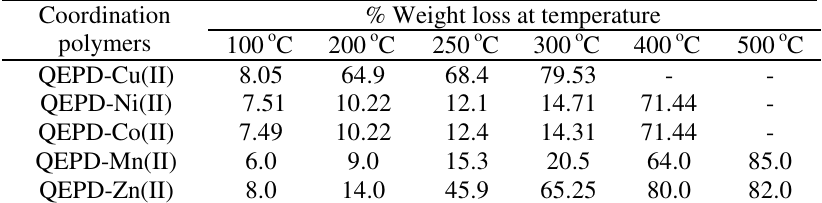
Table 2. Thermogravimetry Analysis (TGA) of the coordination polymer of